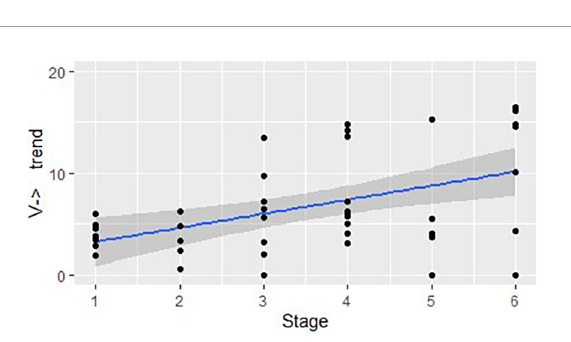
FIGURE2 The developmental trend in structures that start as a verb and change their class: correlation between the stages of linguistic development and the mean number of structures used in each DCP (represented by dots), per 100